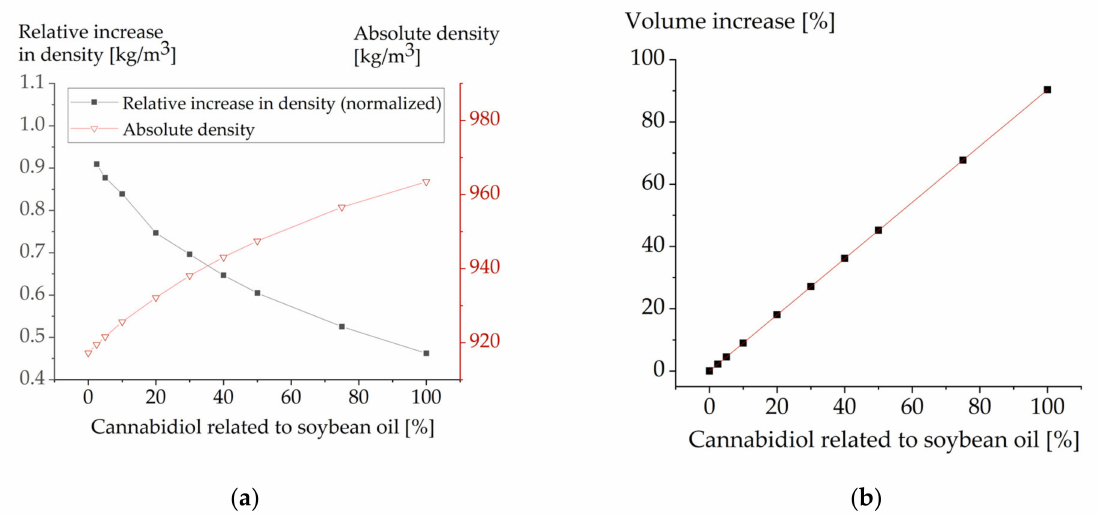
Figure 3. ( a ) Effect of cannabidiol on the density of soybean oil, demonstrated as density and calculation of the relative increase in density normalized to the cannabidiol concentration. ( b ) Simulated volume increase of soybean oil with increasing concentrations of